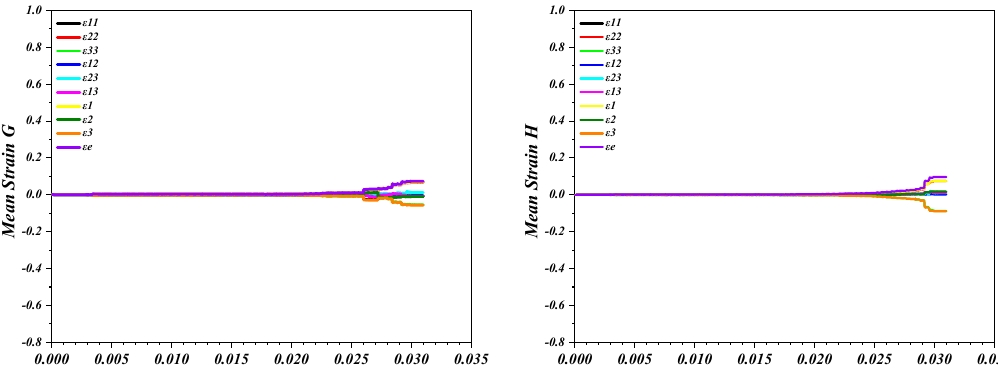
Figure 6. Evolution of strain at sections A, B, C, D, E, F, G and H. Except for the above three special areas, element A is in the bending deformation zone, compared with other strains, ε22 and ε33 values are larger, and tend to stabilize after rapid increase, indicating that it is stretched along the forming direction and com- pressed along the thick direction. As presented in Figure 6 of element H in an area far from the mesh aperture, the deformation is similar to that of the short shaft side, but the value is smaller than the short shaft side. According to the three – way stress state, in the bending deformation area, the two sides of the short axis of the circular aperture in the main deformation area and the main deformation area away from the mesh side element, ε2 ≈ 0, ε1 ≈ ε3, can be considered to be subject to shear action, and subject to plane stress state. At the bottom of the truncated cone piece and the main deformation area, ε2 > 0, ε1 + ε1 ≈ −ε3, are in a typical two − way tensile and one − to − one compression mechanical state.